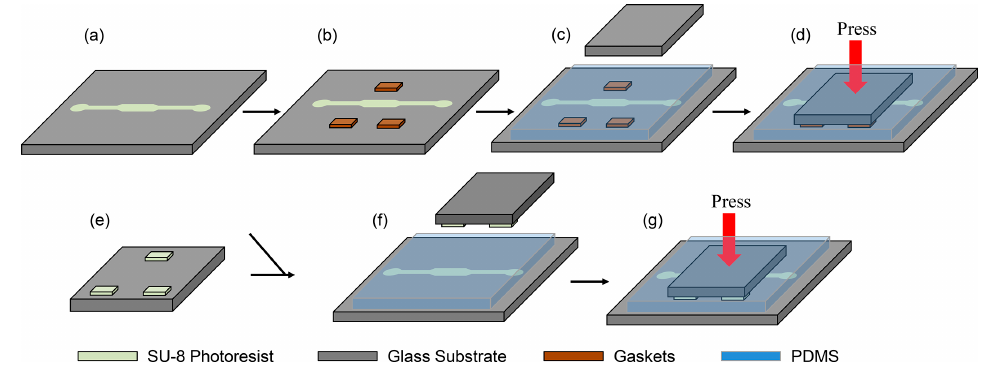
Figure 3. The scheme illustration of the two kinds of fabrication process of one-step molding: ( a – d ) the first process with silicon, polyvinyl chloride (PVC) and PDMS gaskets; ( e , f ) the second process with SU-8 gaskets. ( a ) microfluidic channel of SU-8; ( b ) gasket placement around the channel; ( c ) PDMS casting; ( d ) placement of the cover glass; ( e ) SU-8 gaskets; ( f ) PDMS casting; and ( g ) placement of the SU-8 glass wafer.